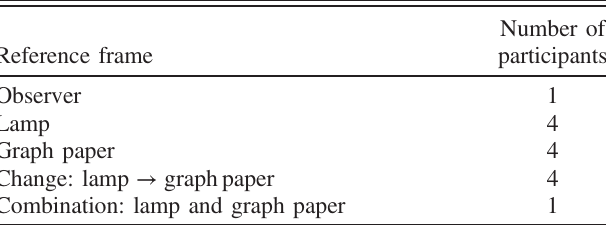
TABLE I. Number of participants per reference frame for uniform light